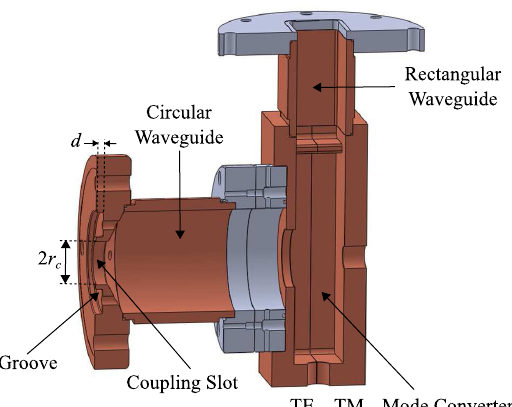
FIG. 8. Conceptual illustration of the rf input coupler including a TE-TM mode converter.